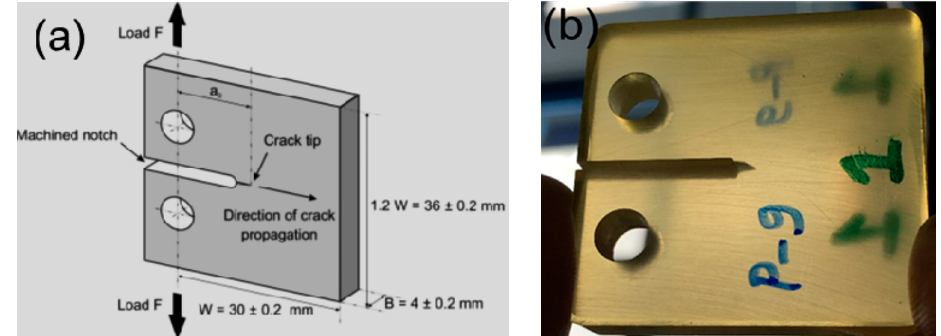
Figure 5. ( a ) Geometry of Compact Tension samples used for fracture testing in mode-I condition. ( b ) Photograph of compact tension sample prepared with artificial sharp